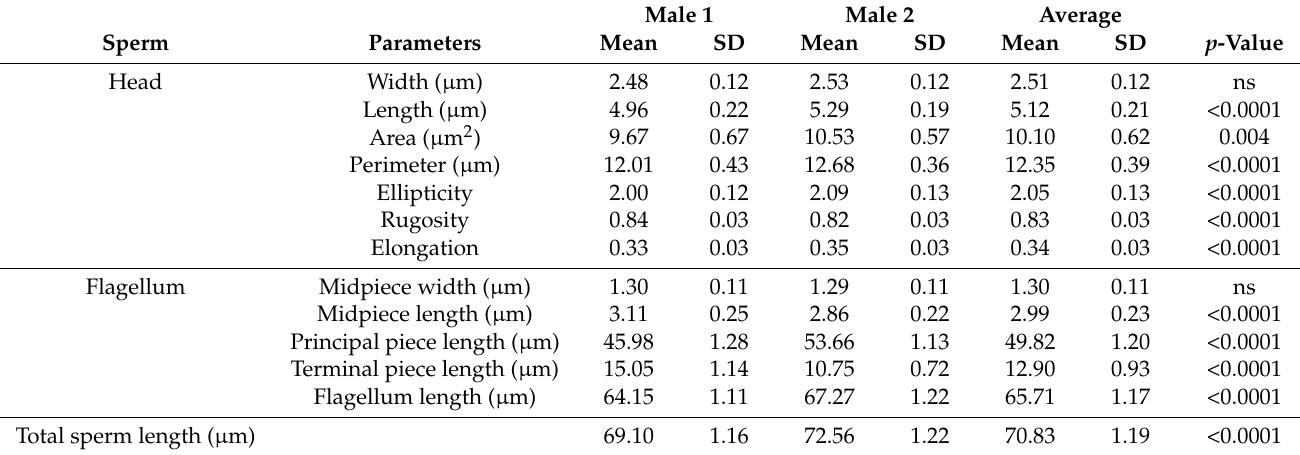
Table 2. Sperm morphometric parameters in bottlenose dolphin ( Tursiops truncatus ). SD = standard deviation. p < 0.05 indicates statistical differences between